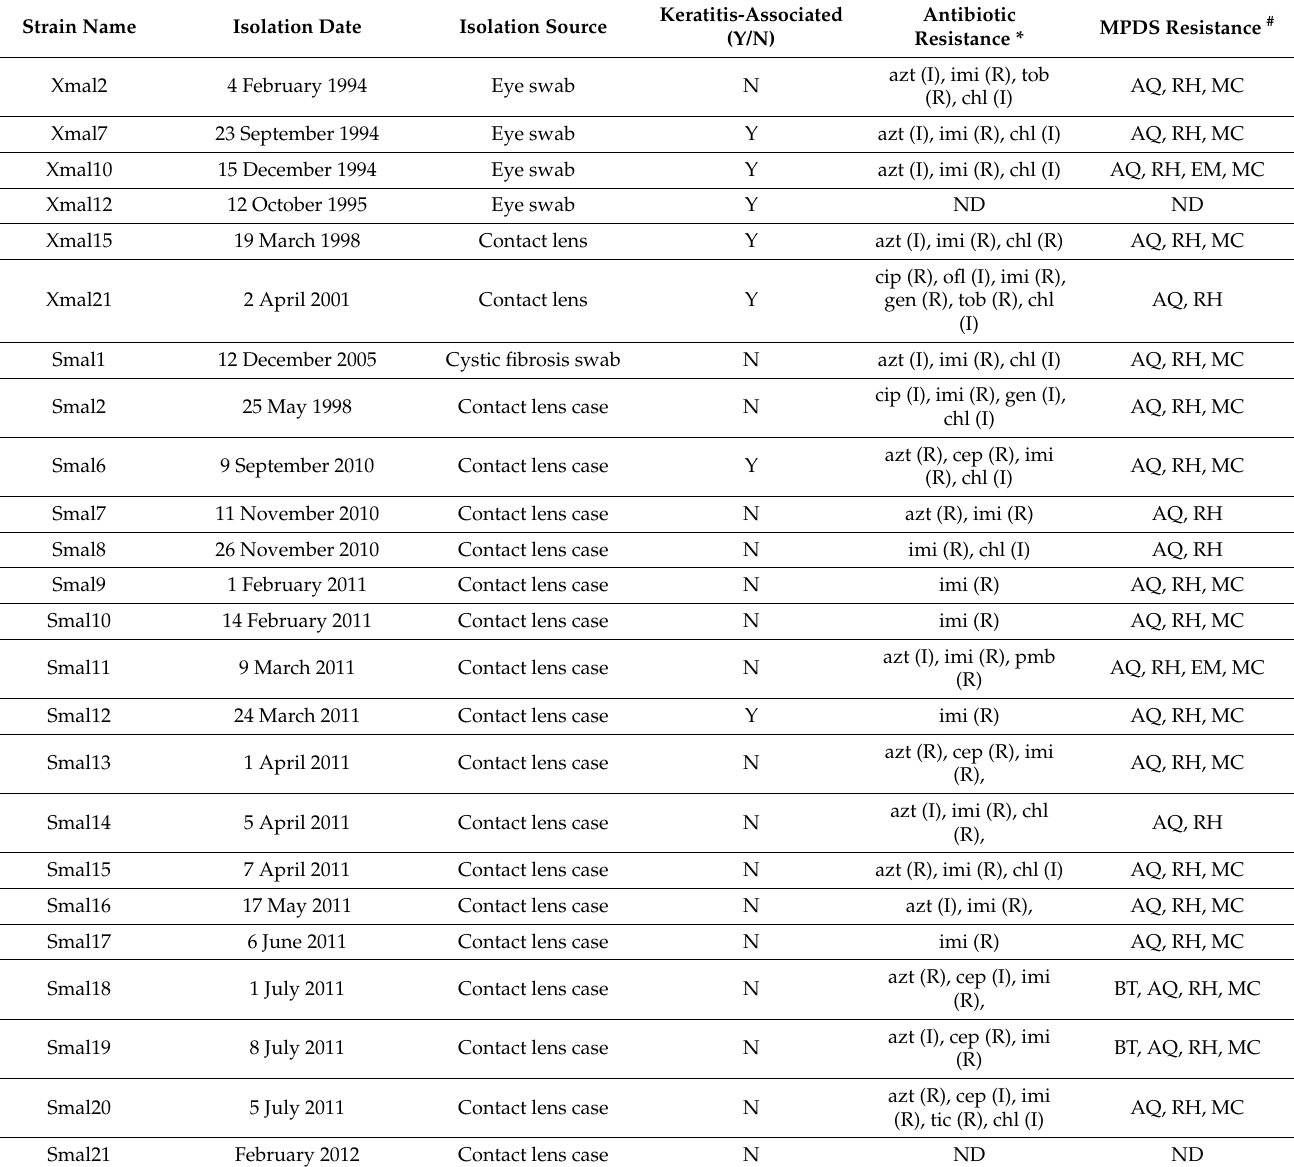
Table 1. The S. maltophilia strains used for susceptibility testing with phage